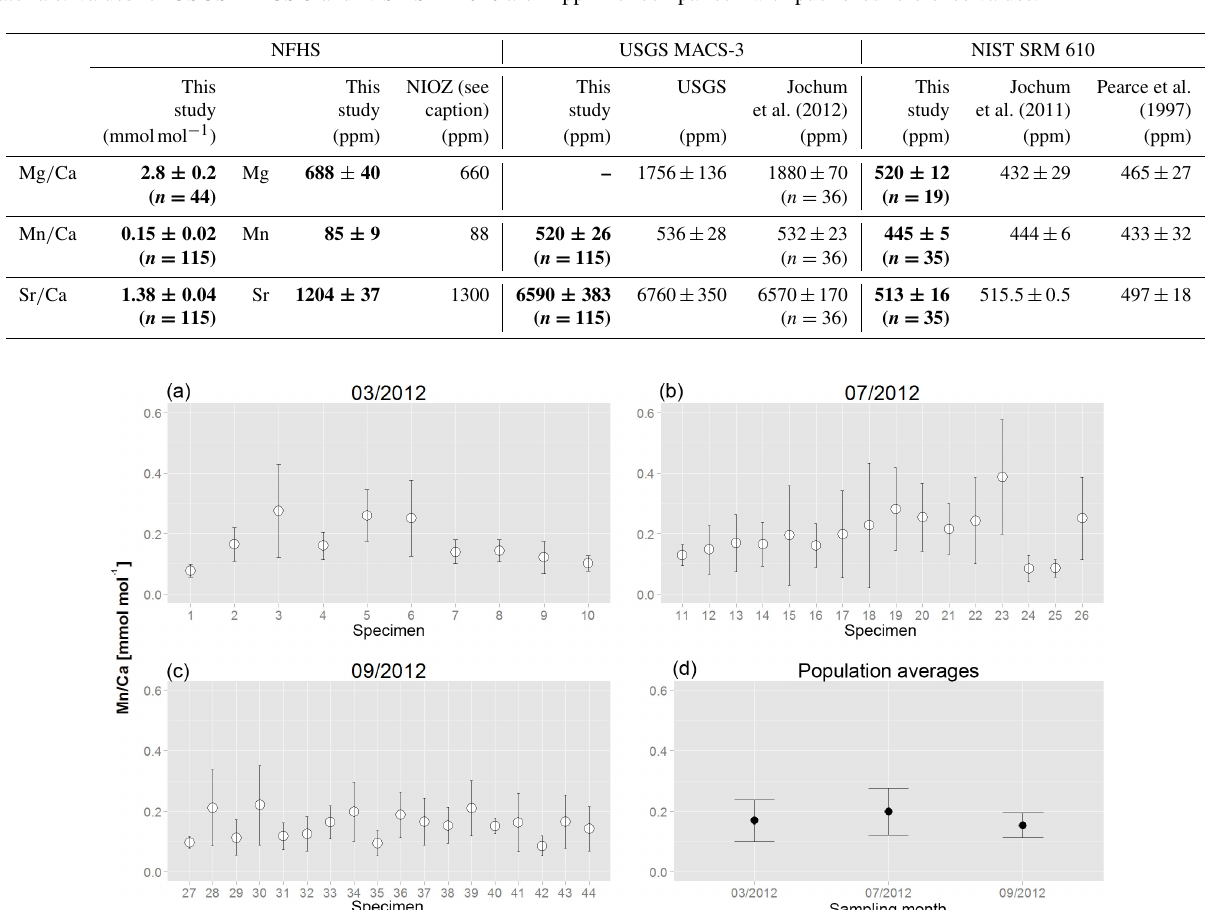
Figure 3. Average Mn / Ca values and SD for all measured chambers of each analysed specimen of A. tepida for the three sampling campaigns ( a : March; b : July; c : September). (d) Population averages with SD calculated on the basis of mean values per specimen of all analysed specimens for each of the three sampling